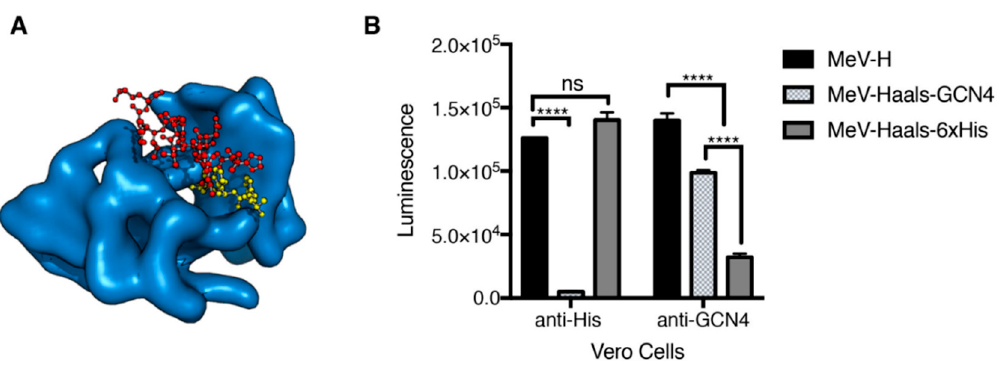
Figure 3. E ff ect of a ffi nity binding in pseudoreceptor fusion levels. ( A ) Crystallographic structures for the tested peptide–pseudoreceptor systems. Crystallographic structures for the scFv binder to GCN4(7P-14P) peptide (PDB [Protein Data Bank] ID 1p4b) with the position of the His-peptide binding are shown (based on structural overlay with the scFv-His peptide structure, PDB ID 1kTR). The scFv binder is shown in a blue surface representation. GCN4(7P-14P) and His peptide binders are shown as red and yellow balls and spheres, respectively. ( B ) A quantitative fusion assay was performed with baby hamster kidney cells bearing the indicated H protein with MeV-F. Vero cells that were transfected with the corresponding pseudoreceptor were used as e ff ector cells. Haals indicates an H protein blind for the natural receptors. Maximum values over a 10-h experiment are shown, with mean (SD) of a representative experiment performed in triplicate. **** indicates p < .0001. MeV-F indicates measles virus–F glycoprotein; MeV-H, measles virus–H glycoprotein; ns, no significance, determined through 1-way analysis of variance with Bonferroni’s multiple comparison test (Used with permission of Mayo Foundation for Medical Education and Research).